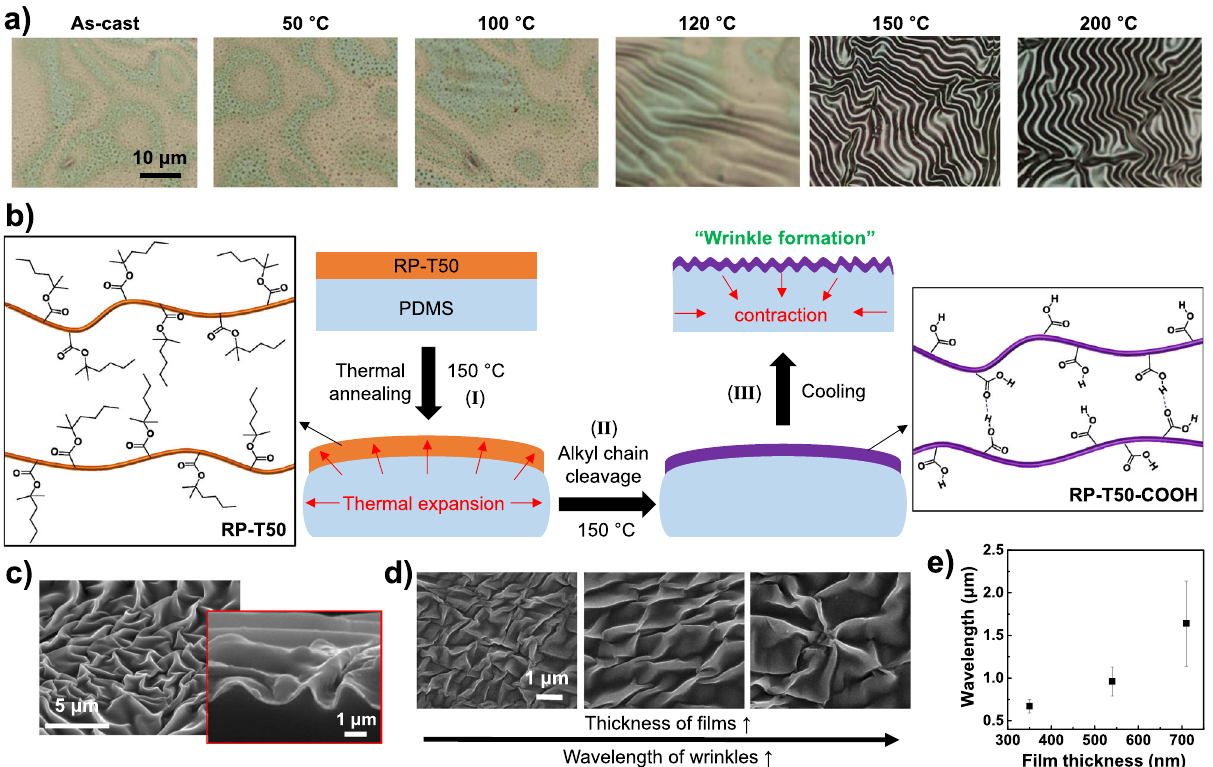
Fig. 3 Mechanism of the wrinkling phenomena on RP-T50 fi lm. a Optical microscopic images of RP-T50 fi lms coated on a PDMS substrate before (as- cast) and after annealing at various temperatures. b Proposed mechanism of spontaneous formation of wrinkled structure in a RP-T50 fi lm upon thermal annealing. c SEM image of the surface of the RP – T50 – COOH fi lm (annealed at 150 °C) on PDMS. Inset: the magni fi ed image of the wrinkled surface with a cross-sectional view. d SEM images of RP – T50 – COOH fi lms with three different thicknesses. As the thickness of the fi lm increases, the wavelength of wrinkles is enhanced. e Plot of the wavelength of wrinkles in RP – T50 – COOH fi lms as a function of fi lm thickness. The thicknesses were measured after annealing RP-T50 fi lms at 150 °C for 12 h. Error bars represent mean ± s.d., with n =